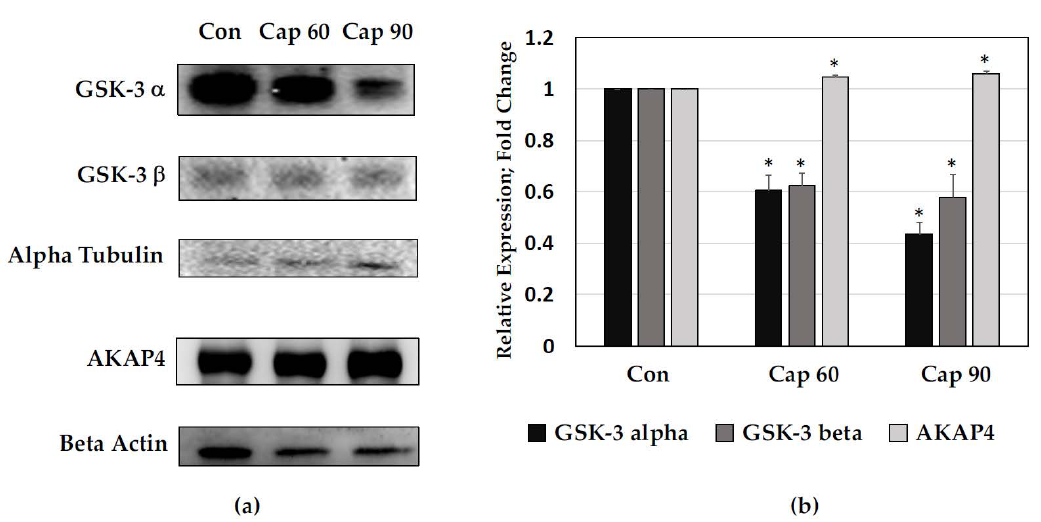
Figure 5. Validation of MS results by western blot analysis for selected proteins. ( a ) Western blot analysis of GSK-3 α , GSK-3 β , alpha tubulin, AKAP4, and beta actin in noncapacitated (Con) and capacitated (Cap 60 and Cap 90) mouse sperm. ( b ) Relative expression of GSK-3 α , GSK-3 β , and